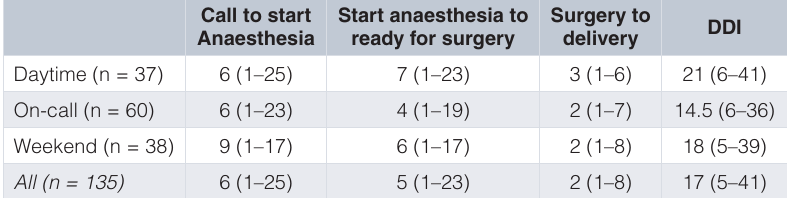
Table 2. Time events for the different work shifts: daytime, on-call during the week and at weekends. Data are presented in minutes as median (range).